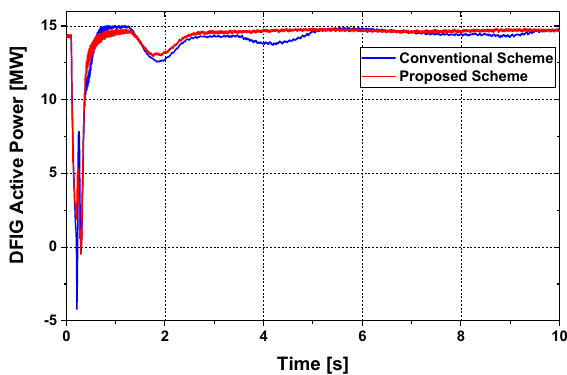
Figure 15. Active Power response of SCIG.